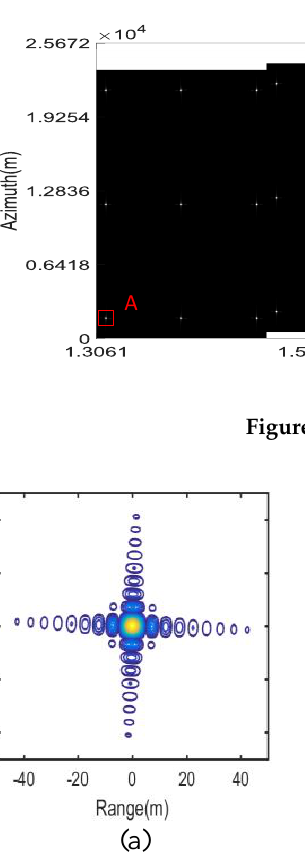
Figure 7. ImPulse Response (IPR) of the targets of the proposed scheme. ( a ) Target A; ( b ) Target B; and ( c ) Target C.